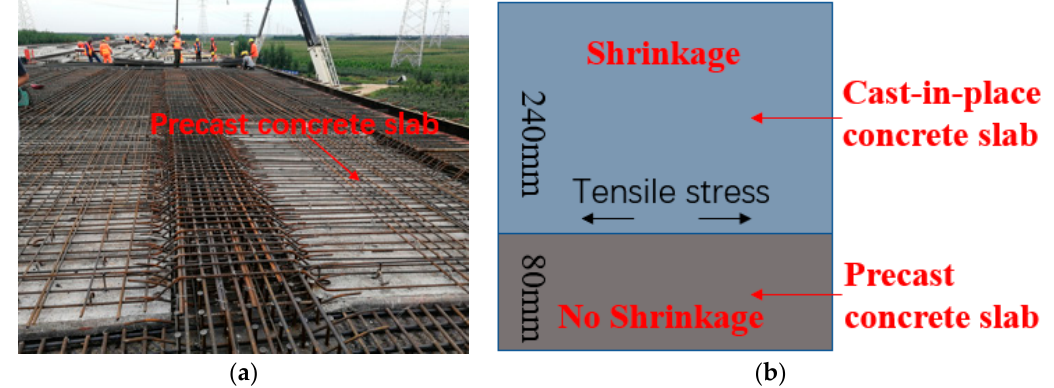
Figure 2. Structure of bridge deck: ( a ) construction site; ( b ) sketch map.